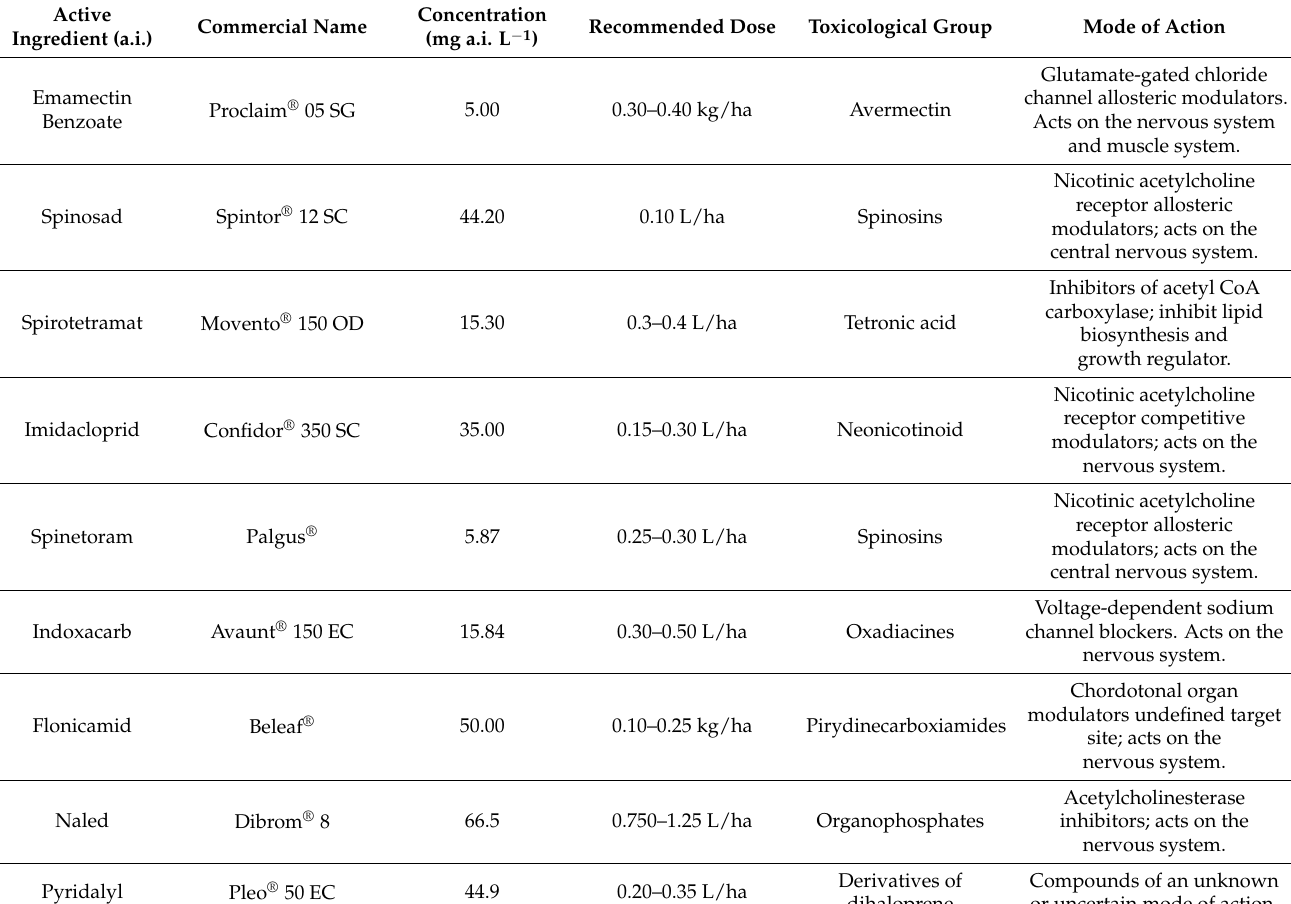
Table 1. Insecticides and doses evaluated in acute and residual toxicity tests in adults of the parasitoid Diadegma insulare